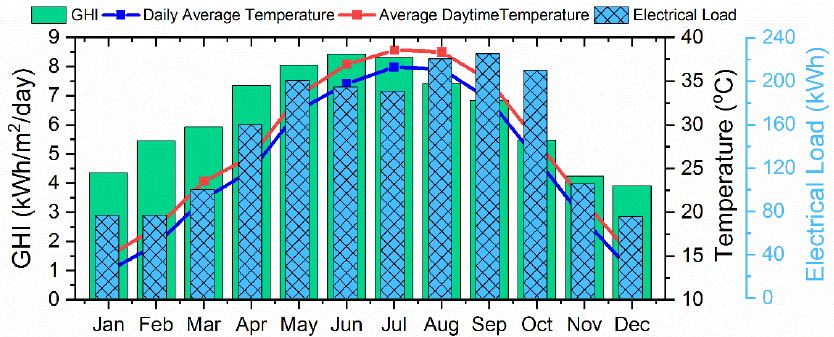
Figure 1. Daily average global horizontal irradiance (GHI), daily average and daytime average temperatures and load profile.